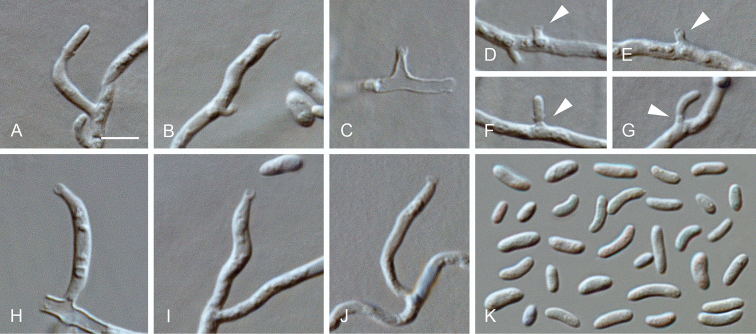
Cadophora
obscuraA–J conidiophores and conidiogenous cells (arrows indicate short necks) K conidia A–K from SNAA–KLM. Scale bar: 5 μm (A applies to B–K).